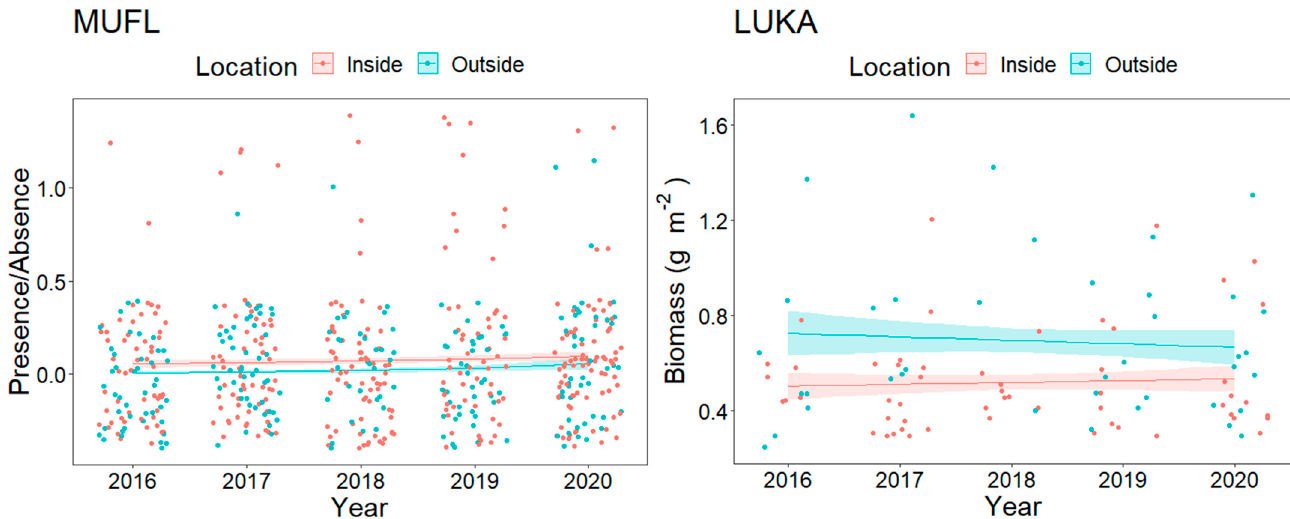
Figure 5. GLM plots of significant trends in both presence/absence and biomass data among locations (MUFL-presence/absence and LUKA-biomass). Species codes are as follows: Mulloidichthys flavolineatus (MUFL) and Lutjanus kasmira (LUKA).